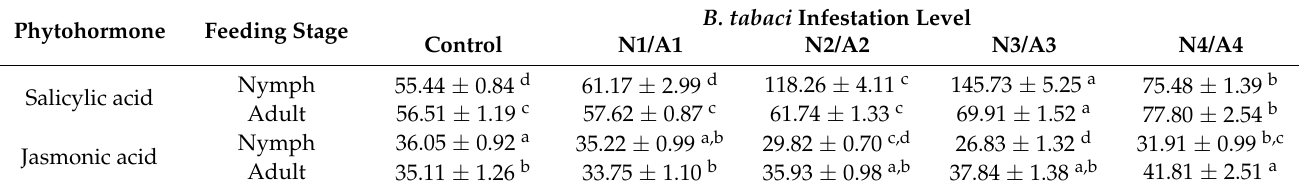
Table 1. Effects of infestation by whitefly adults and nymphs on defense phytohormone contents (ng/g FW) of systemic leaves of tobacco plants.